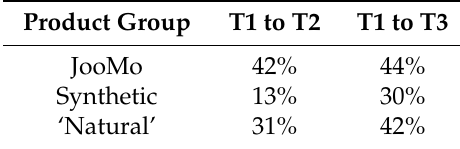
Figure 5. Diversity using Chao1 index of all time points of the JooMo group samples. ( A ) shows T1 and T2 with a significant increase over time. Samples normalised to a read depth of 2364 sequences; ( B ) shows T1 and T3 with a significant increase over time. Samples normalised to a read depth of 2366 sequences; ( C ) shows T1, T2 and T3 with a significant increase in diversity. Samples were normalised to a read depth of 2361 sequences.